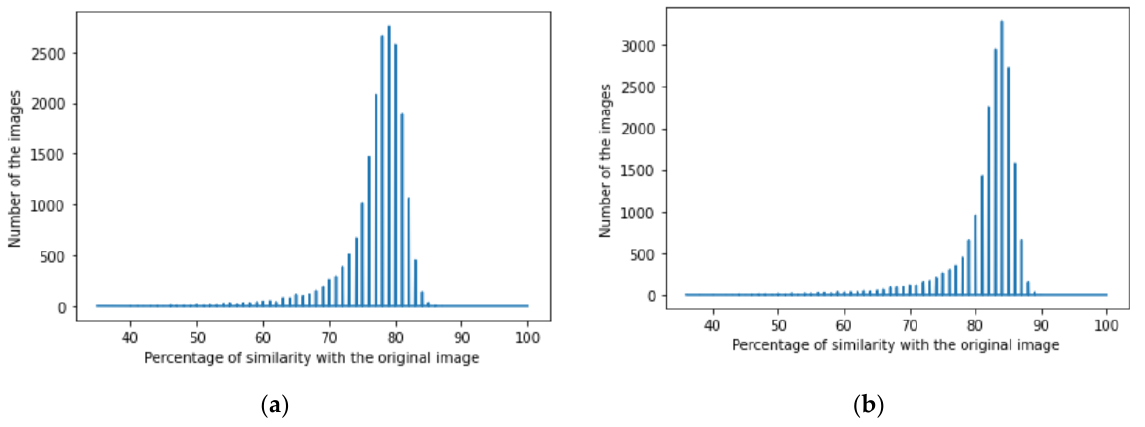
Figure 12. The histogram of similarity between the predicted denoised image and the original image in the case of impulse noise: ( a ) one autoencoder with separable convolutional neural networks; ( b ) dual autoencoder with separable convolutional neural networks.